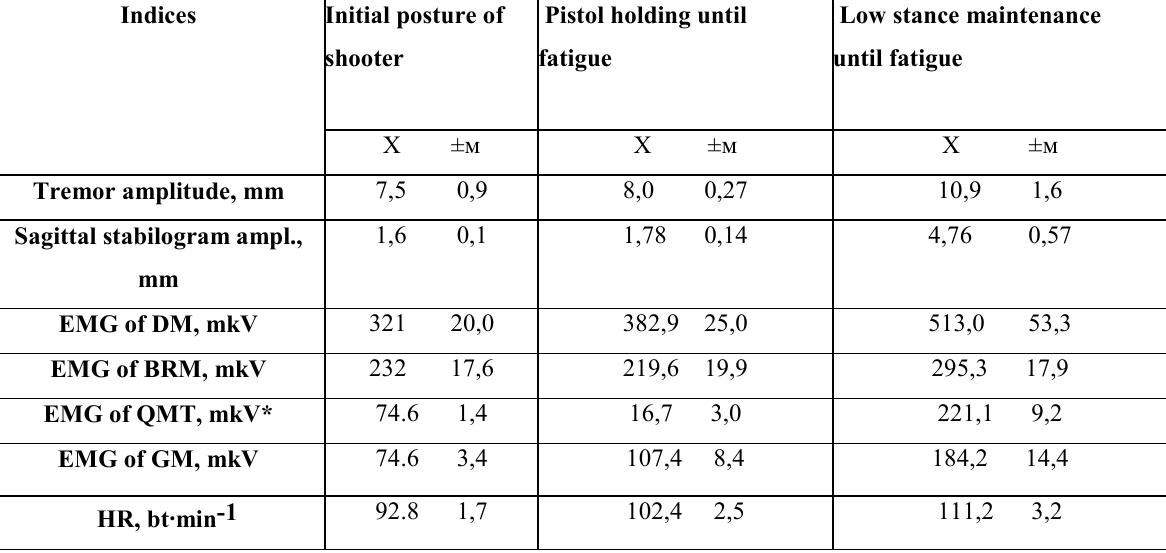
Somatovegetative indices and accuracy of shooting under different conditions of upright posture